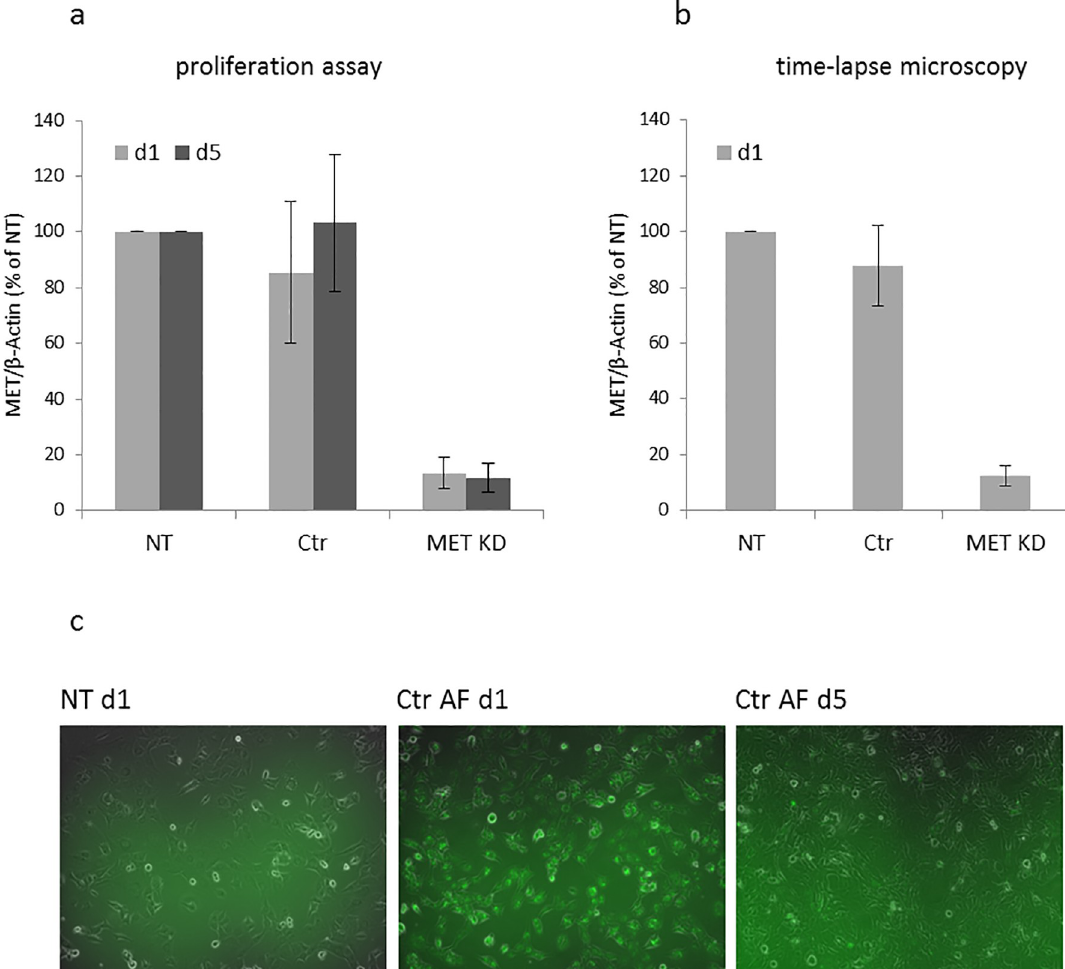
Fig 5. Confirmation of MET knockdown during phenotypic assays. Hs746T cells were transfected with MET siRNA (MET KD) or control siRNA (Ctr). Non-transfected cells (NT) were analyzed in parallel. MET knockdown was confirmed for the duration of cell proliferation assay (a) and time-lapse microscopy (b) by Western blot. MET knockdown on day 1 (d1) after transfection corresponds to plating of cells for proliferation assay and knockdown on day 5 (d5) corresponds to the end of the assay. For time-lapse microscopy, MET knockdown corresponds to the assay start. The mean of three biological experiments with standard deviation is shown. The presence of Alexa Fluor labeled siRNA control (Ctr AF) was monitored on d1 and d5 (c).